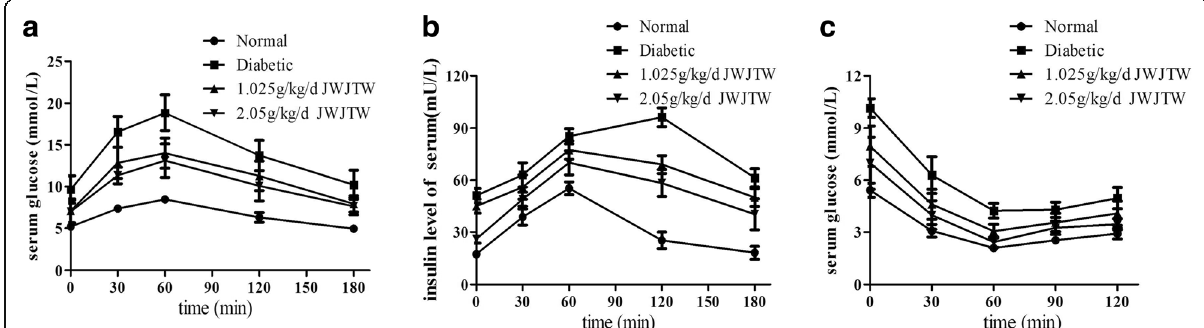
Fig. 3 Effects of JWJTW on glucose tolerance, insulin release and insulin tolerance in diabetic rats. a GTT of diabetic rats; b IRT of diabetic rats; c ITT of diabetic rats. Normal: normal group rats without streptozotocin (STZ) or high-sucrose-high-fat diet; Diabetic: diabetic rats induced by STZ and a high-sucrose-high-fat diet; 1.025 g/kg/d JWJTW: diabetic rats treated with 1.025 g/kg/d Jia-Wei-Jiao-Tai-Wan; 2.05 g/kg/d JWJTW: diabetic rats treated with 2.05 g/kg/d Jia-Wei-Jiao-Tai-Wan. GTT and IRT: Oral glucose tolerance test and insulin release test, respectively, performed on diabetic rats that were orally administered 2.2 g of glucose per kg after 12 h of fasting ( n = 10). ITT: insulin tolerance test performed on diabetic rats injected with 0.4 U insulin per kg after 4 h of fasting ( n = 10)